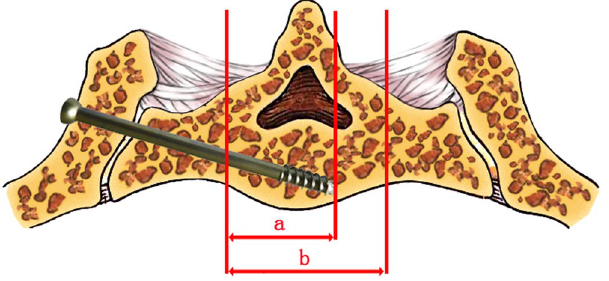
Figure 5. The depth of the cannulated lag screw (a), which is inserted into the body of the first sacral vertebra, should be no more than 2/3 of the vertebral body (b).